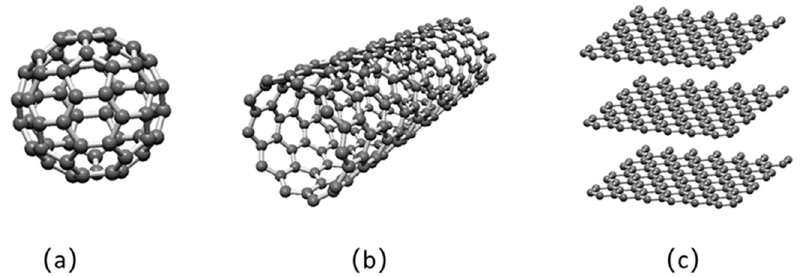
Figure 1. Schematic of the carbon nanomaterials in different dimensions: ( a ) zero-dimensional fullerene, ( b ) one-dimensional carbon nanotubes, ( c ) two-dimensional graphene.